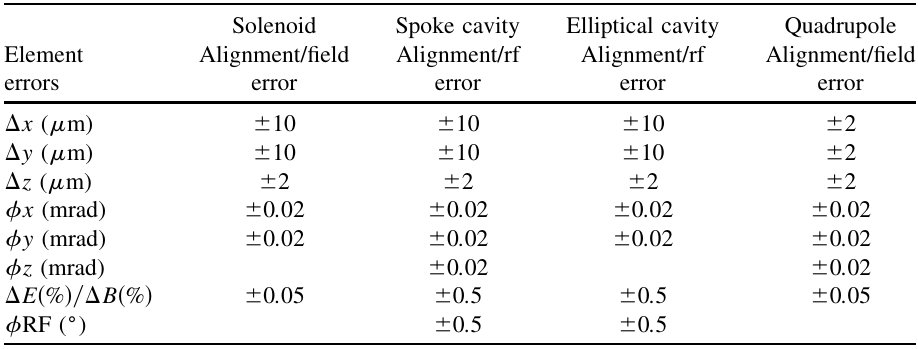
TABLE VII. Amplitudes of dynamic errors used for error studies Solenoid Spoke cavity Elliptical cavity Quadrupole Element errors